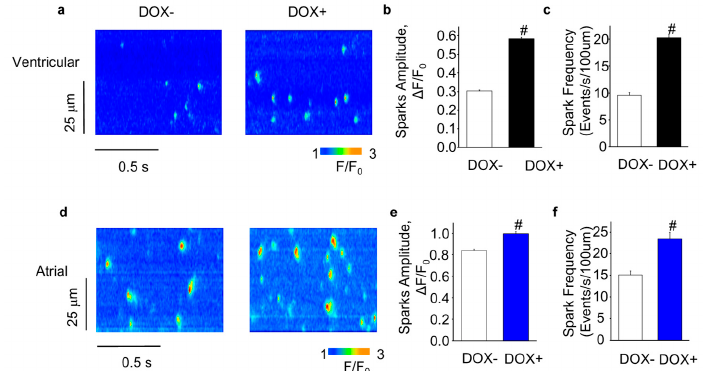
Figure 6. Acute SERCA2a overexpression increased SR Ca leak in CASQ2 KO myocytes. ( a ) representative line-scan images from permeabilized ventricular myocytes. Amplitude; ( b ) and frequency ( c ) of Ca sparks in ventricular myocytes; ( d ) representative line-scan images from permeabilized atrial myocytes; Amplitude ( e ) and frequency ( f ) of Ca sparks in atrial myocytes. # p < 0.05 vs. DOX − .